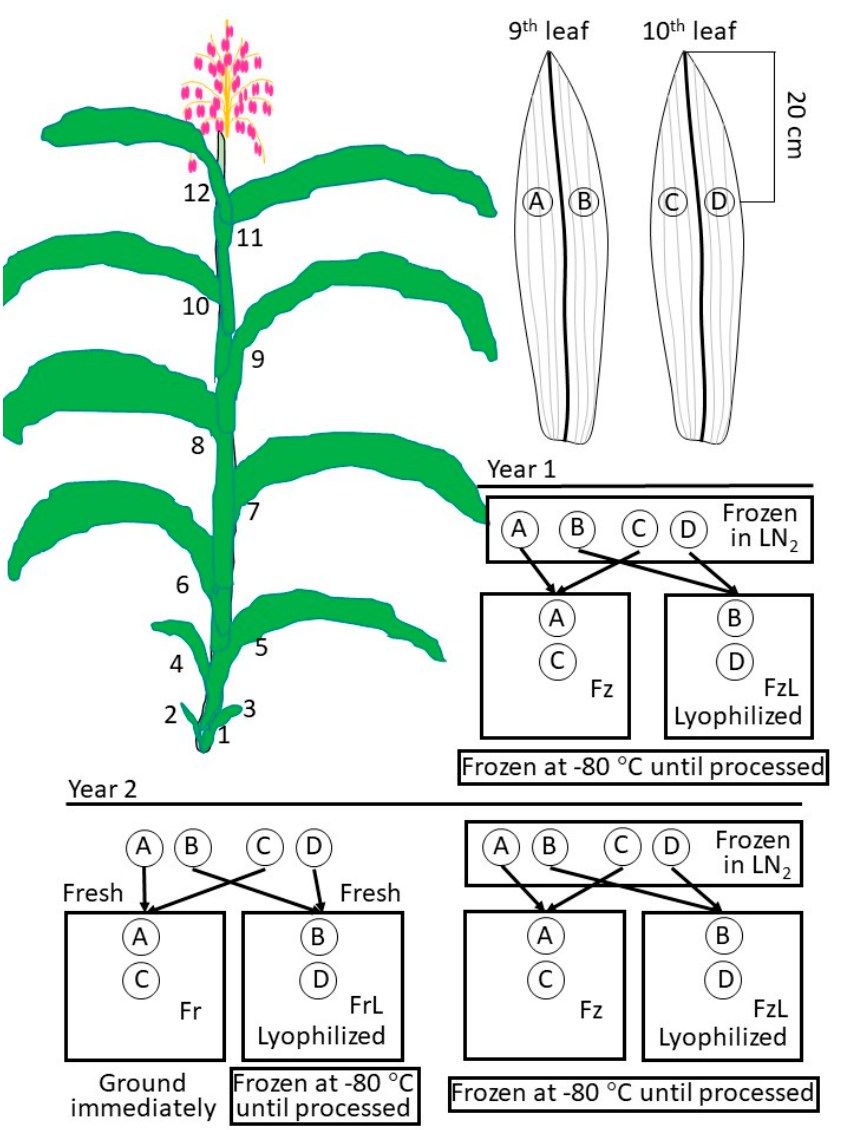
Figure 1. Graphic showing the sampling of the maize leaf. Maize plants (W22, raffinose synthase ( rafs ) [GRMZM2G150906] mutant or null segregant (NS)) were grown to maturity before leaf disks